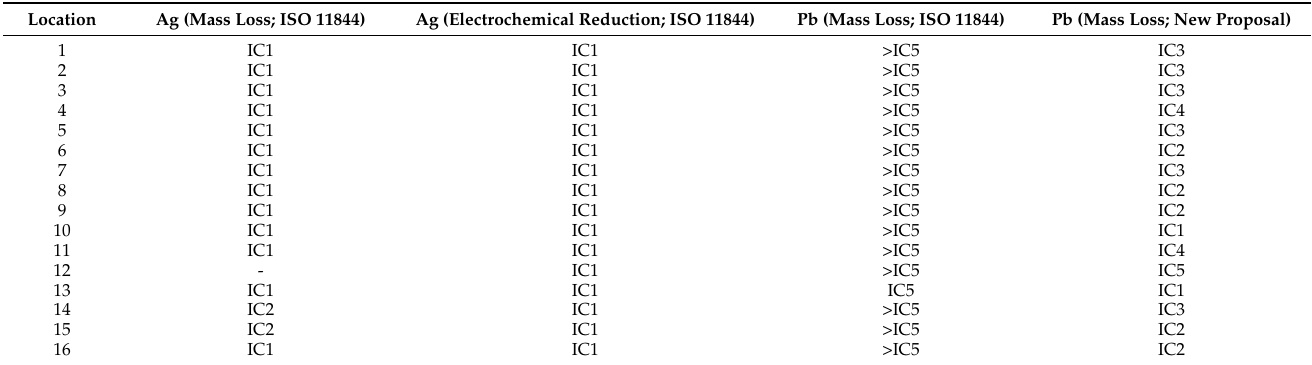
Table 3. Corrosivity categories of exposure